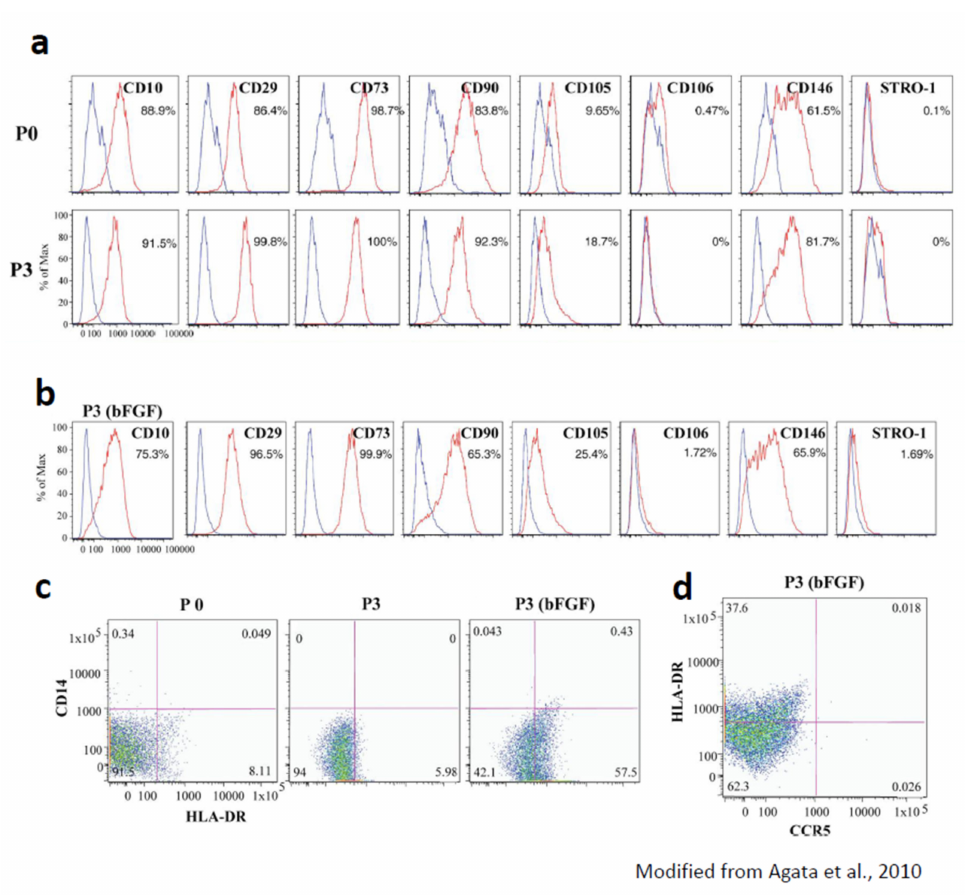
Figure A1. Flow cytometry of BMSCs at passages 0 and 3 was positive for CD10, CD29, CD73, CD90, CD105, and CD146 but almost negative for CD106 and STRO-1 ( a ). BMSCs cultured in the presence of bFGF were positive for CD10, CD29, CD73, CD90, CD105, and CD146 and slightly positive for CD106 and STRO-1 ( b ). Cultivation with bFGF increased the HLA-DR-positive fraction in BMSCs, and this HLA-DR-positive fraction was negative for chemokine receptor-5 (CCR-5) and CD14 ( c , d ). BMCs: bone marrow stromal cells; bFGF: basic fibroblast growth